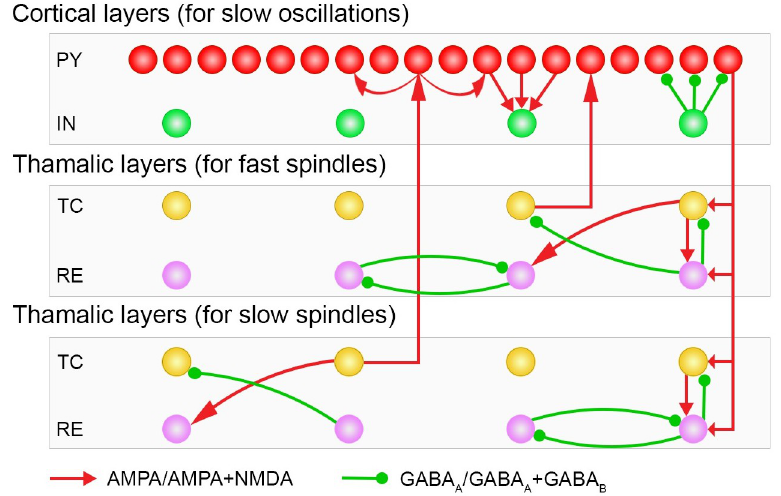
Fig 1. The thalamocortical network geometry and connection scheme. The network is comprised of six cell layers. The top two consist of cortical PY and IN neurons. The middle two layers are thalamic TC and RE neurons for fast spindle generation, and the bottom two thalamic TC and RE neuron layers generate slow spindles. The cortical PY cells layer contains 200 neurons, all other layers contain 40 neurons. Small green-filled circles symbolize GABA A Rs or GABA A Rs+ GABA B Rs, and corresponding connections. Red arrowheads represent correspondingly AMPARs or AMPARs+ NMDARs